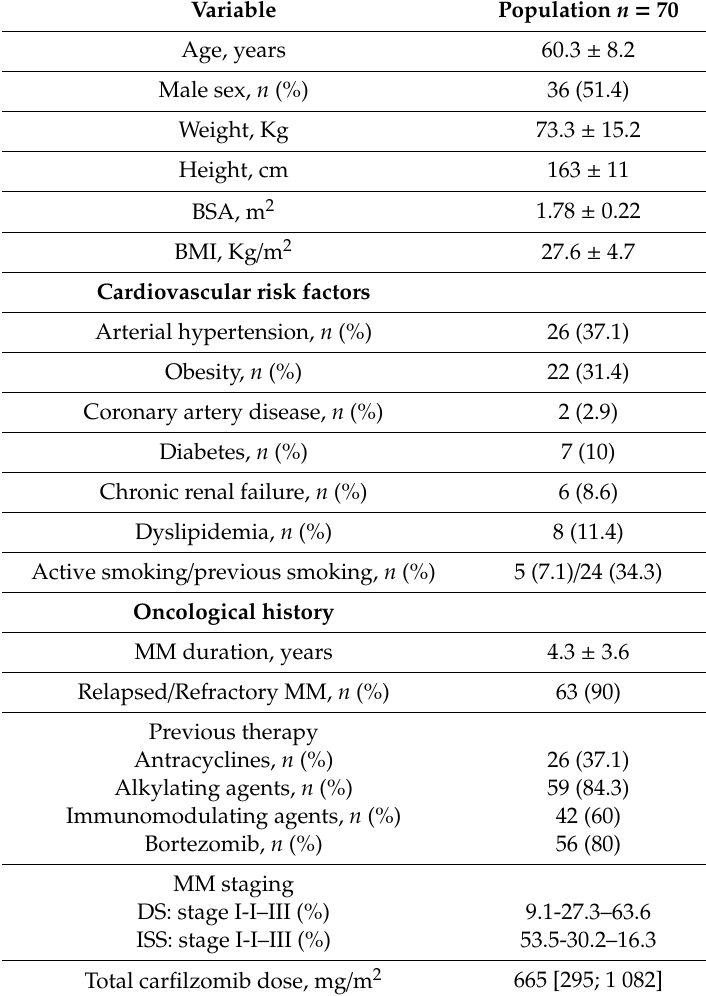
Table 1. General characteristics, cardiovascular risk factors, and oncological